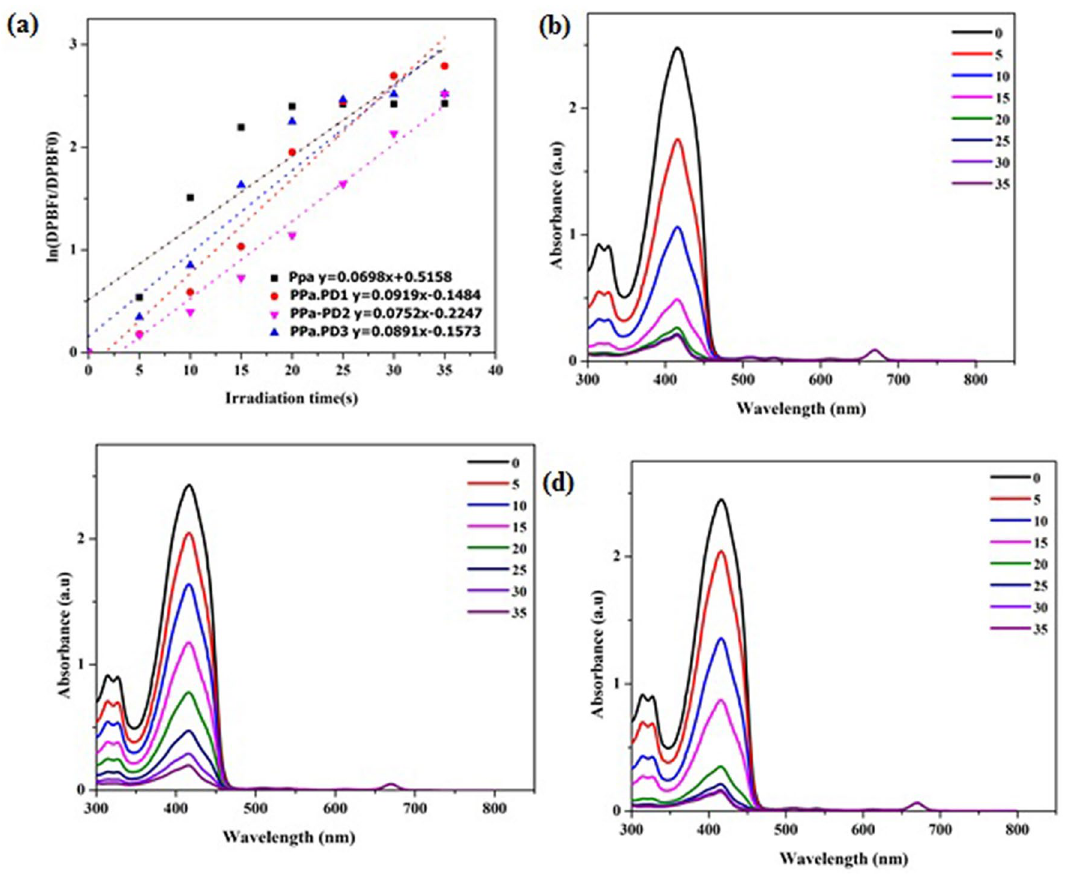
Figure 5. ( a ) ROS generation in nano-hybrids. Photodecomposition of DPBF in ( b ) PPa-PD1, ( c ) PPa-PD2, ( d )